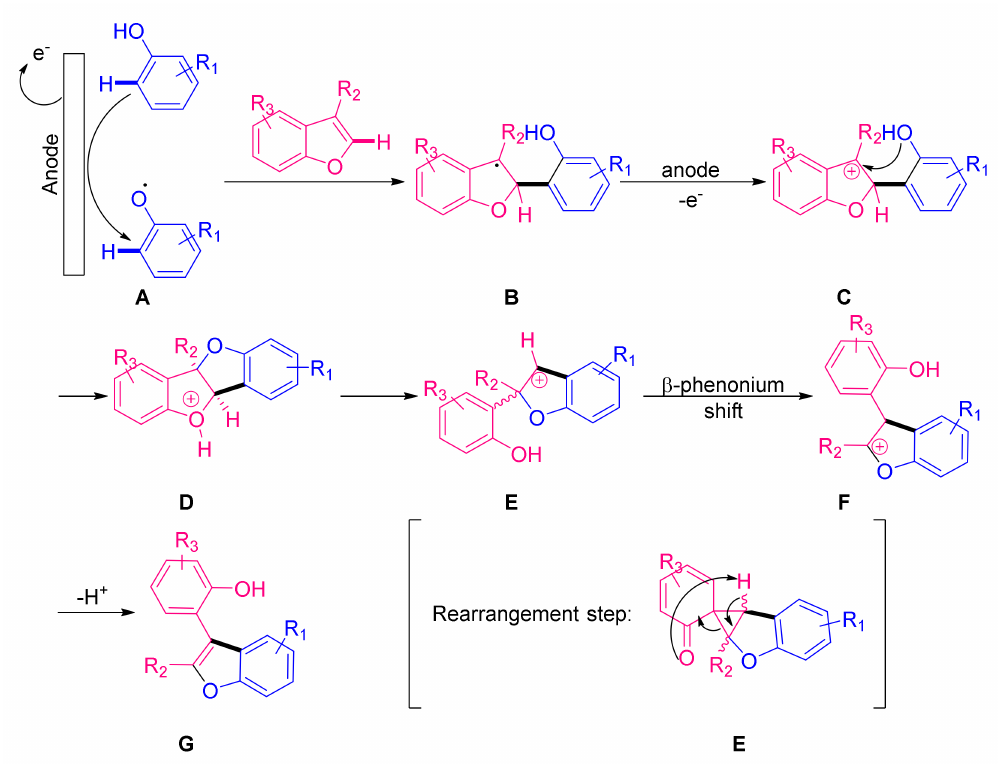
Scheme 19. Proposed mechanism for the cross-coupling between phenol and 3 -substituted benzofuran.